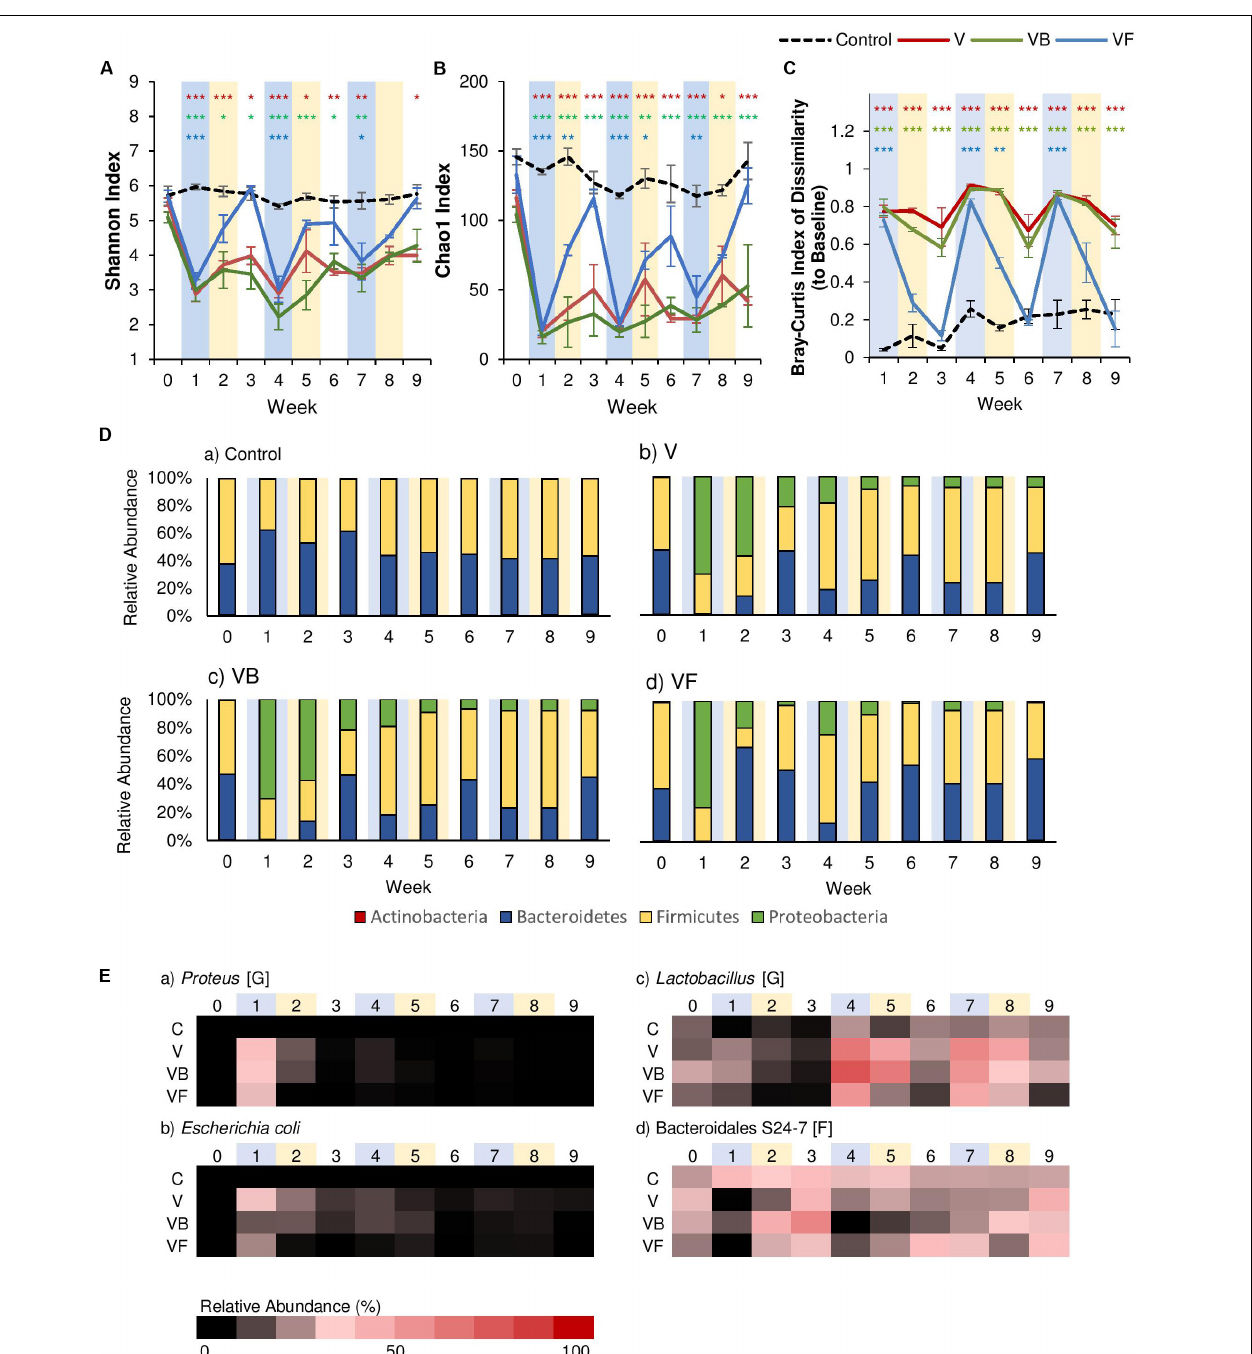
FIGURE 3 | The effect of recovery treatments on the gut microbiome after vancomycin. Vancomycin administration was followed by either natural recovery (NR), Bifidobacterium bifidum (PR), or fecal transplants (FT), and changes to the gut microbiome were observed over time. Alpha diversity measured by (A) Shannon Index and (B) Chao1 Index for each treatment over time ± standard error. (C) Bray-Curtis Index of Dissimilarity vs baseline for each treatment over time ± standard error. The Bray-Curtis Index was used to quantify the amount of microbial shift from the first day of the experiment (baseline) for each individual. Colored asterisks indicate significance vs control for NR, PR, and FT groups based on Two-Way rm-ANOVA and Tukey’s HSD post hoc test (* p < 0.05, ** p < 0.01, *** p < 0.001). Data for the control samples are indicated as the black dotted line, with NR (V) groups in red, PR (VB) groups in green, and FT (VF) groups in blue. (D) The microbial community at each time point at the phylum level for (a) control, (b) V, (c) VB, and (d) VF. (E) Heat map of taxa that significantly changed after antibiotic administration. Significant taxa were identified using factor analysis (factor loading > 0.4). The lowest taxonomic rank for which information was available is indicated in square brackets (F: family, G: genus). Weeks shaded in blue indicate weeks in which antibiotics were administered, and weeks shaded in yellow indicate weeks in which a recovery treatment (natural recovery, probiotics, or fecal transplants) were administered.